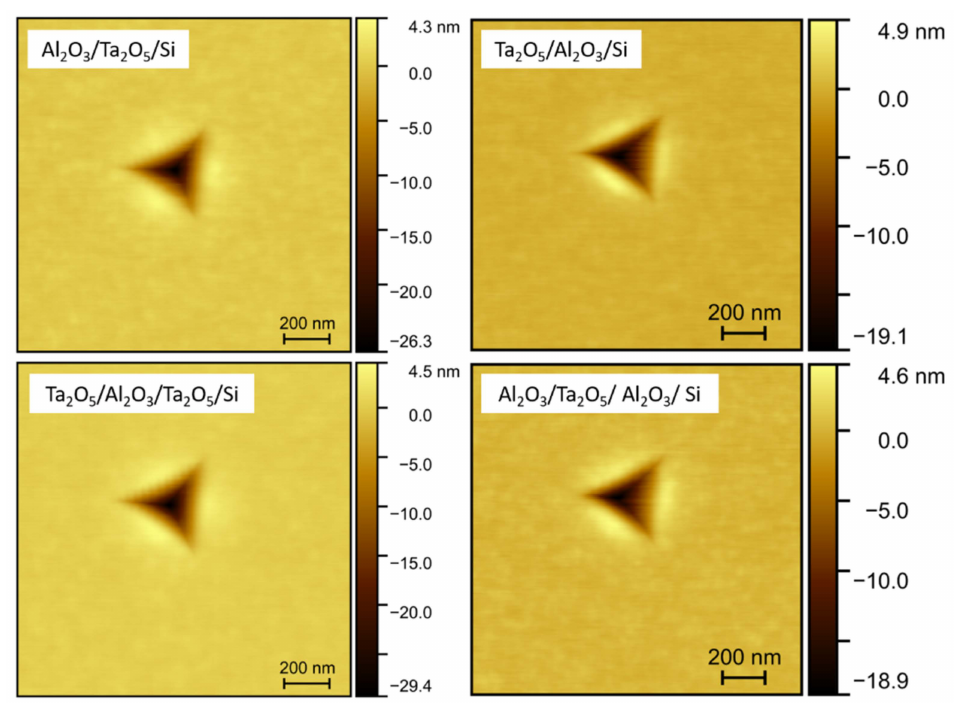
Figure 6. Scanning probe microscopy images of idents on double- and triple-layered